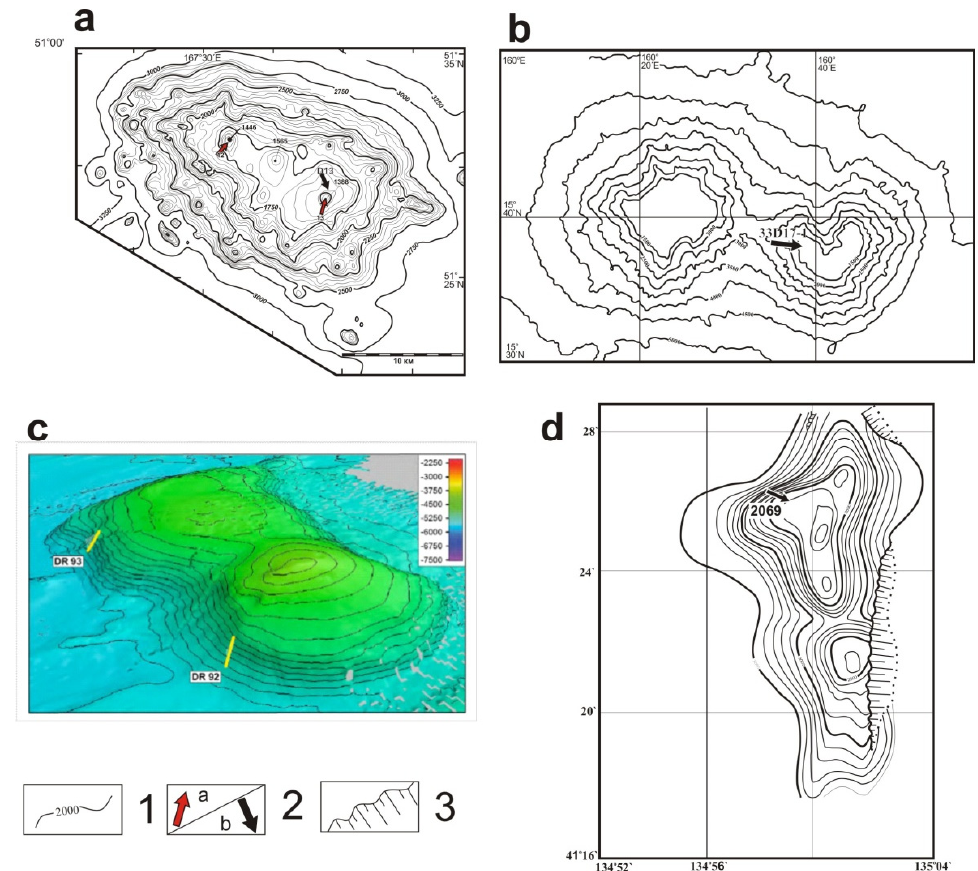
Figure 2. Bathymetry of ( a ) Detroit guyot’s northern superimposed structure [27]; ( b ) Zubov guyot (our unpublished data); ( c ) seamount between Krusenstern and N.N. FZ, which has been named “Gummi Bear” seamount by the cruise participants, according to its bathymetric appearance (view from ESE to WSW) [33]; ( d ) Belyaevsky underwater volcano [36]. 1—isobath; 2—dredging stations, a—after [29], b—our results; 3—cliff.